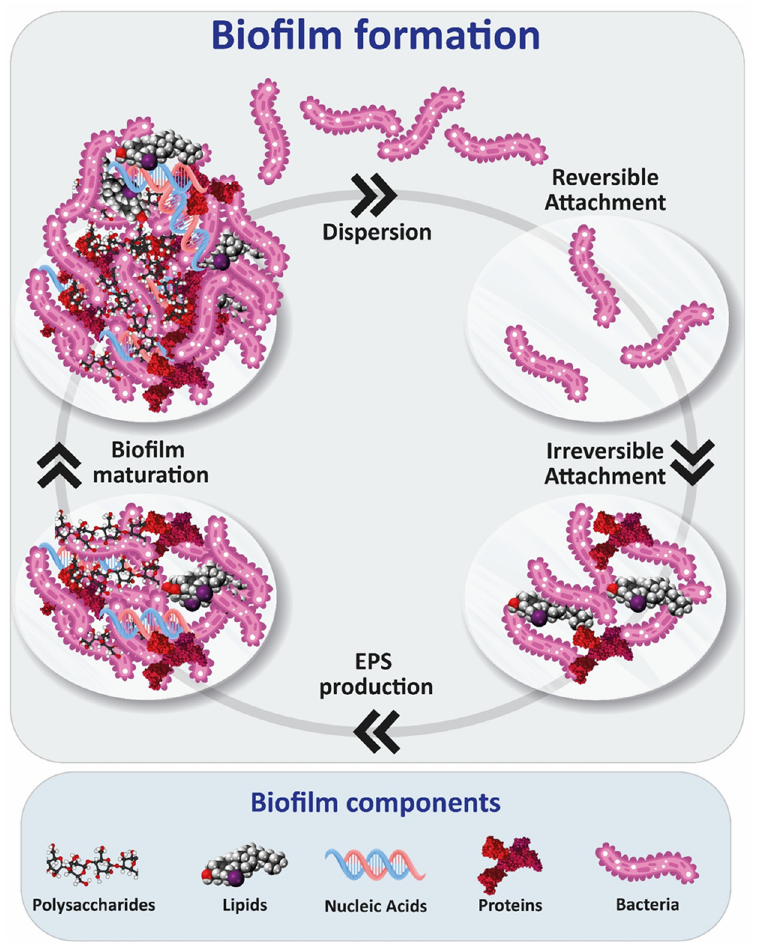
Figure 1. Stages of biofilm formation: reversible attachment, irreversible attachment, EPS production, maturation and dispersion/detachment phase.